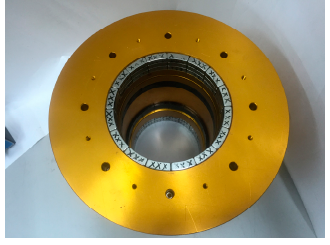
Figure 14. The rotor of HMB and PMB.